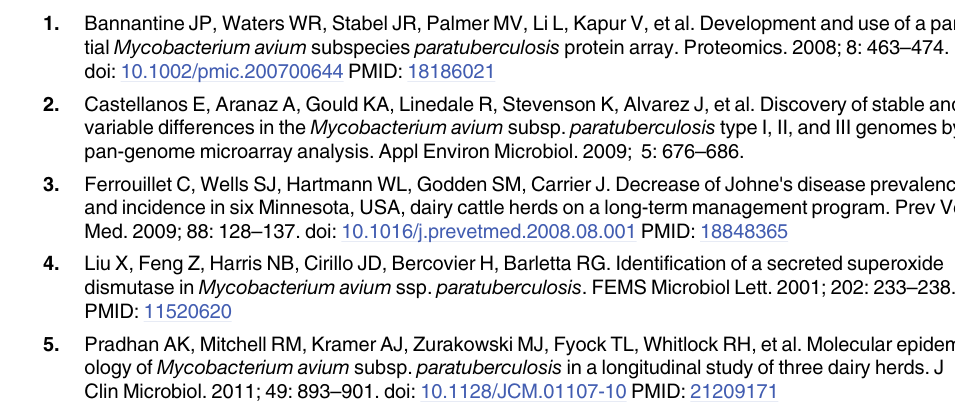
S2 Table. Fragment analysis results for the 4 SSR loci of all 85 Map isolates derived from 18 Newfoundland animals. SSR-types were designated as M1-M40 based on their